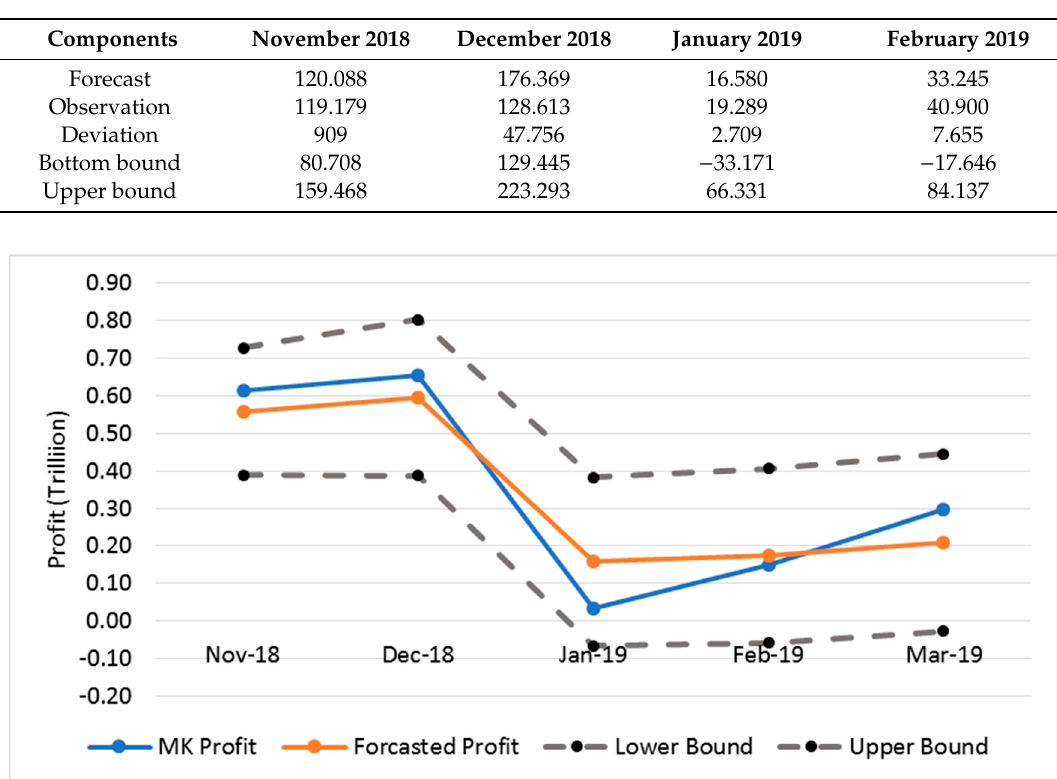
Figure 9. Forecast profits in 95% confidence interval of Bank B. Table 7. Forecast profit of Bank B in IDR trillion.